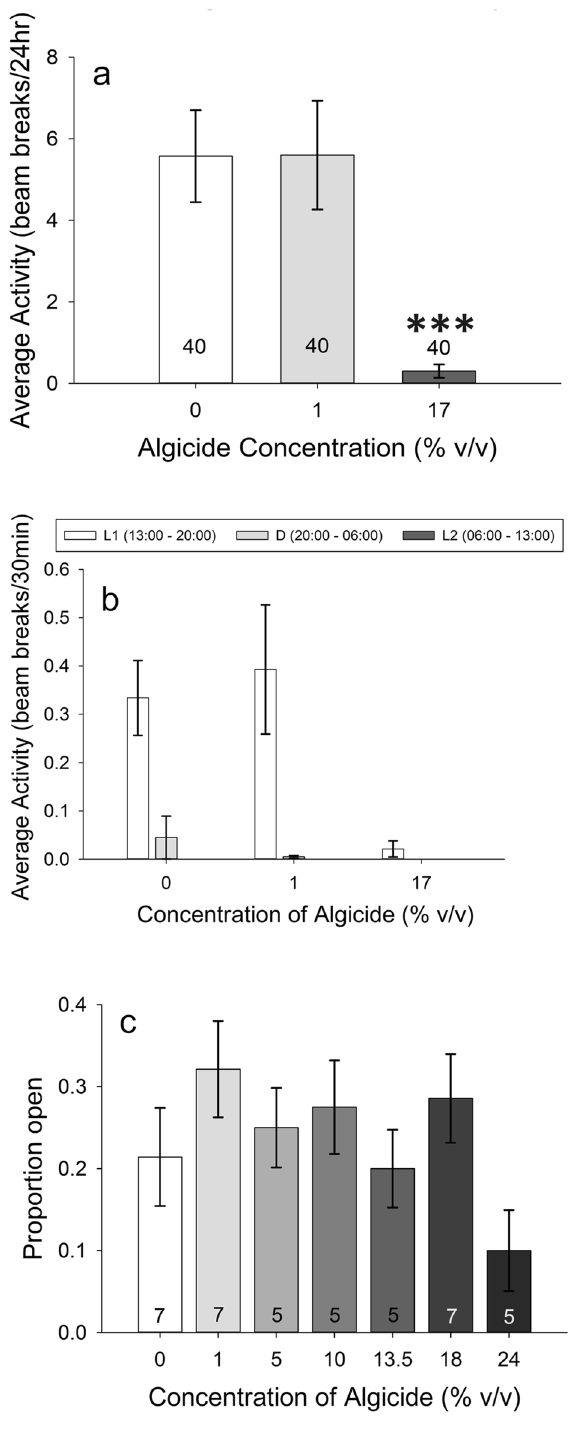
Figure 6. Activity levels of Crassostrea virginica ; numbers on the bars represent sample size. ( a ) Activity level of C. virginica larvae as a function of algicide concentration over a 24-h period. Animals were first pre-exposed to the listed concentrations of algicide for 24 h, then placed into tubes of algicide-free water for activity measurements over the subsequent 24 h. ( b ) Data from ( a ) broken down into activity per 30 min and separated by time of day. ( c ) Adult C. virginica activity, given as proportion of individuals open. Animals were assessed in containers in pairs, creating a set of containers where the proportion open was either 0, 0.5, or 1. These were checked at 4 time points and scored, data were averaged across time points to calculate an average proportion open for the container, then containers were averaged and plotted (n values are given on each bar). (*** p <